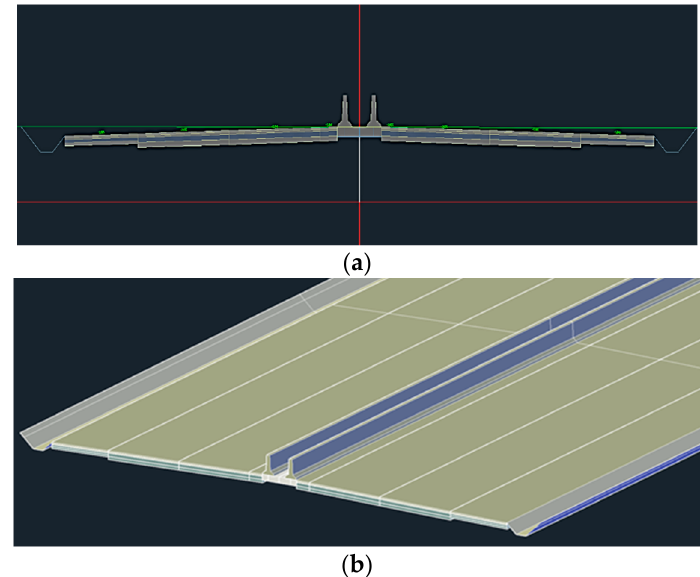
Figure 10. Freeway Type A Section, ( a ) Cross sectional view of the road; ( b ) 3D view.